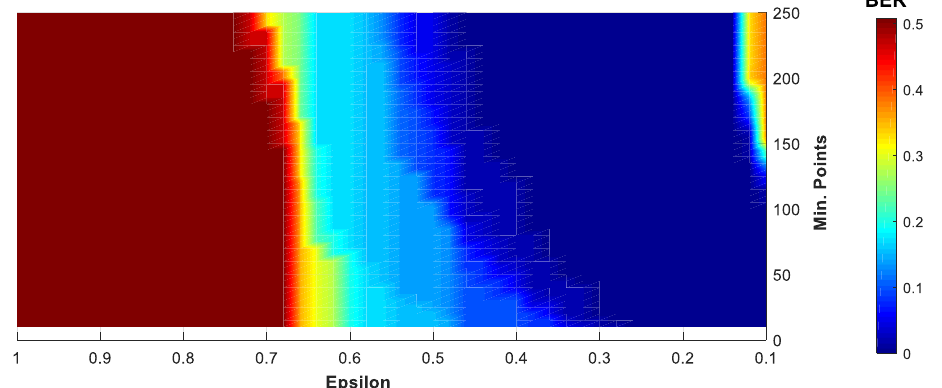
Figure 3. DBSCAN optimisation for 16 QAM transmission over 50 km at +10 dBm of launch power: bit-error-rate (BER) vs. ε (“Epsilon”), Min. Points = 4.